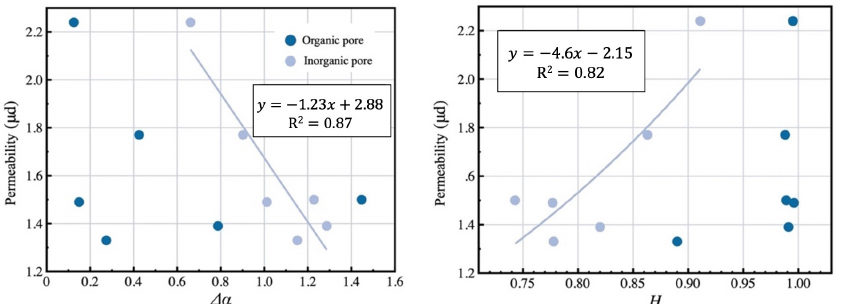
Figure 8. The relationships between multifractal characteristic parameters of organic and inorganic pores and